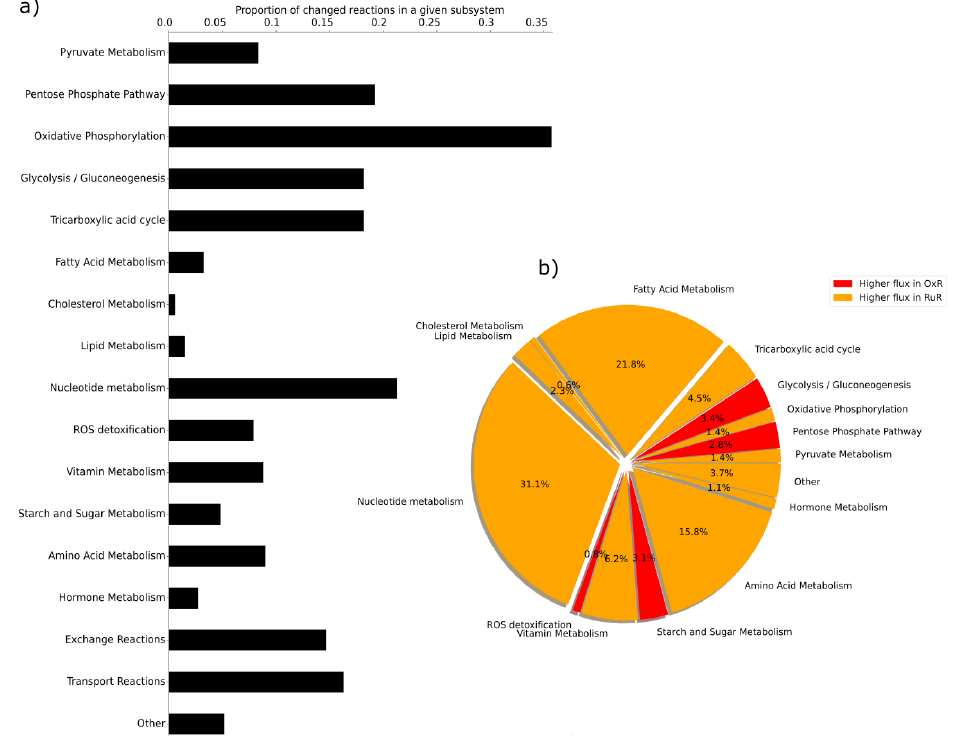
Figure 6. Predicted differences in the metabolic fluxes of ruthenium- and oxaliplatin-based resis- tances after growth rate and medium normalization. Both intracellular and extracellular metabolite constraints were applied to generate four instances of the HCT-specific GSMMs (oxaliplatin (OxR) and BOLD-100/KP1339 (RuR) and their sensitive parental counterparts (WT and WT-DMSO, respec- tively)) as described in the Materials and Methods. A parsimonious thermodynamic flux variability analysis (pTFVA) was done on each model instance. Each set of flux values was divided by the corresponding flux through biomass (Figure S1), thus normalizing for differences in growth. Flux values were then feature-scaled to lie between 0 and 1 and the flux values obtained in the drug- resistant instances were divided by the flux values of the corresponding control instances, thus normalizing for difference in medium composition. ( a ) The relative changes in flux between OxR and RuR instances were calculated and the total number of reactions that showed an absolute relative difference greater than 15% in relative upper and lower flux values were counted for each subsystem. The proportion of reactions that are significantly different in each subsystem is shown as black bars. Subsystems for which no relative changes in flux between the two resistant instances were observed were omitted from the figure for clarity. ( b ) Percentage of reactions in a subsystem which were identified as significantly different out of all reactions that were identified as significantly different between the two conditions are shown as a pie chart. Subsystems for which the total flux values were higher in OxR are shown in red. Subsystems for which total flux values were higher in the RuR are shown in orange. The subsystems transport reactions were omitted from this analysis as together they make up over 95% of the significantly different